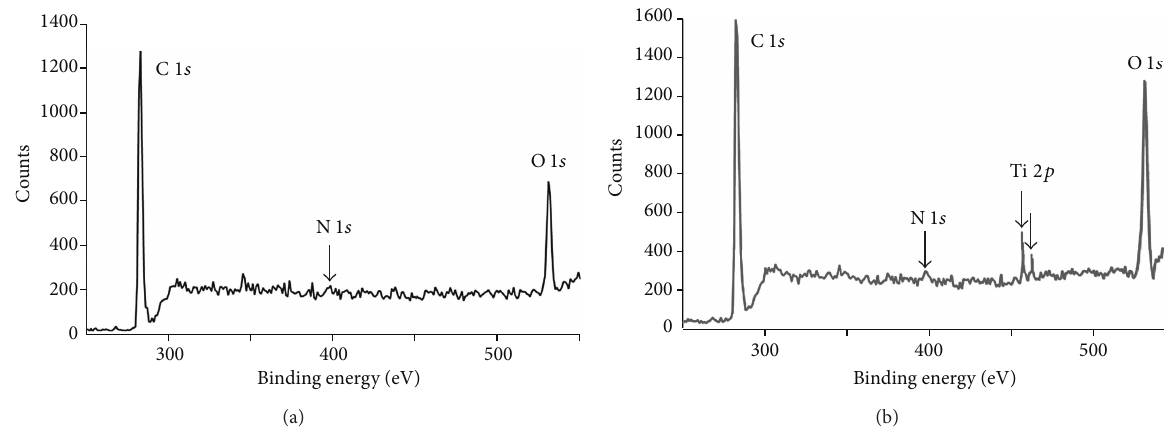
Figure 1: X-ray photoelectron spectra of neat epoxy polymer and ET-10 composite films.